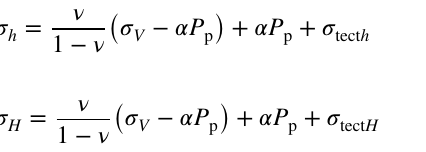
Compare the estimated value of 10,802 psi at the depth 3076 m with the real pore pressure of 10,805 psi (Table